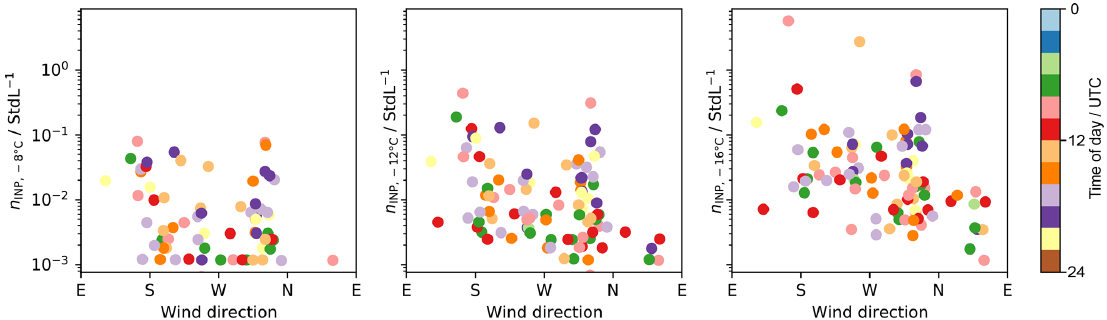
Figure A1. INP concentrations at − 8, − 12, and − 16 ◦ C measured at WFJ as a function of wind direction. The color indicates the time of sampling.